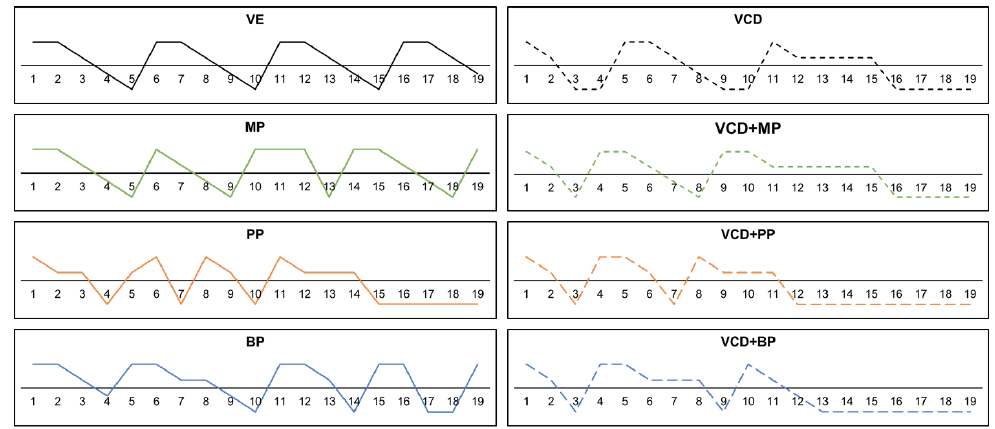
Figure 1. Effects of VCD and parabens on estrus cycles. The estrus cycle of the rats was monitored